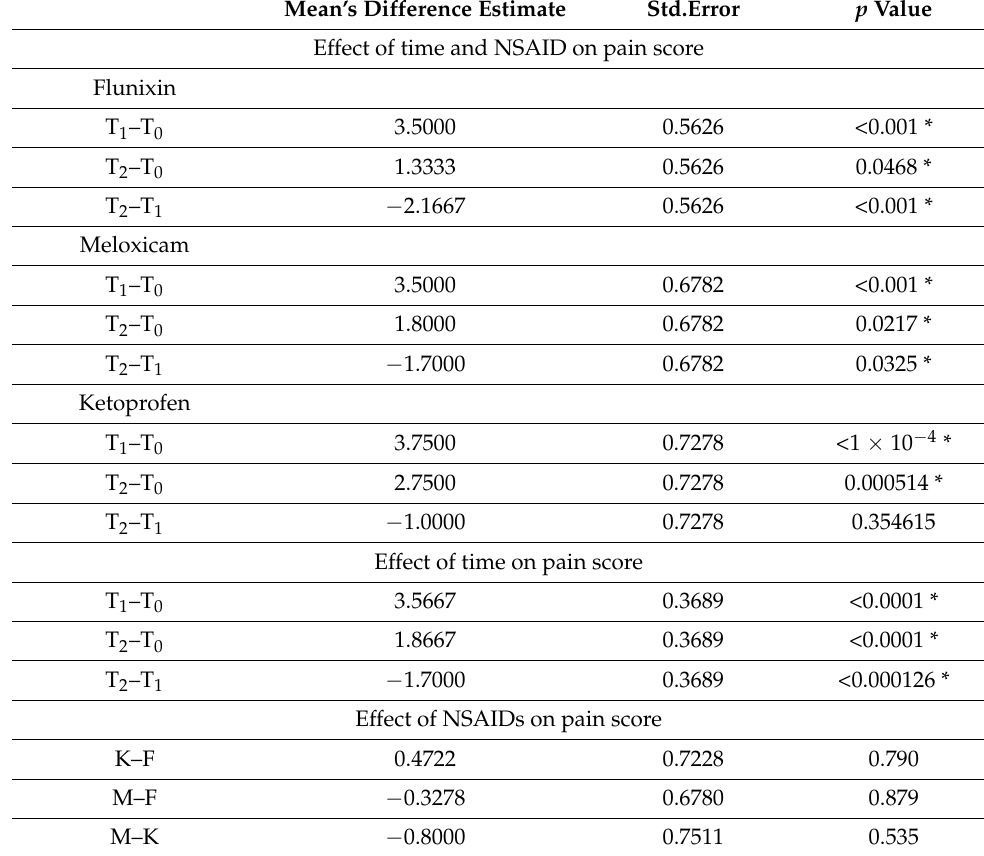
Table 3. The effect of time, NSAIDs and both on mean pain scores. Pain scores were assessed before NSAID administration (T 0 ), after recovery from anesthesia (T 1 ) and after the second NSAID administration (T 2 ). The statistical results of multiple comparisons of means using post-hoc Tukey tests are given.